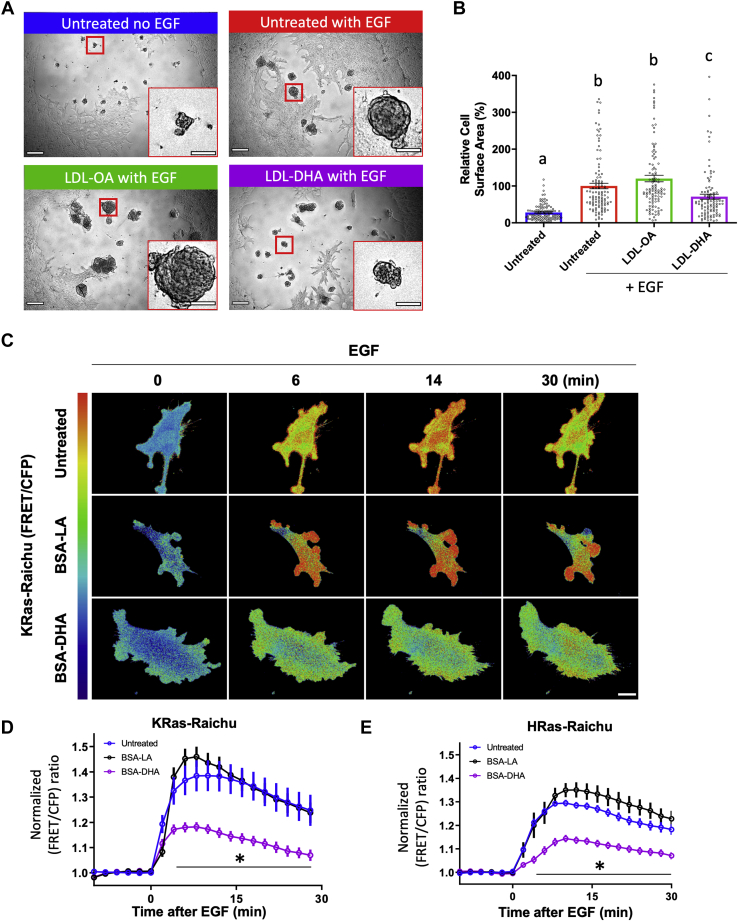
Exogenous supplementation with DHA reduces EGFR-dependent proliferation and downstream signaling in vitro. A: Representative images of colonoids grown with indicated treatments. Scale bar, 300 and 100 μm. B: Quantification of colonoid surface area after 10 days of treatment. Data represent mean ± SE. Number of organoids examined per treatment, Untreated No EGF = 112, Untreated + EGF = 109, LDL-OA + EGF = 109, LDL-DHA + EGF = 112, from eight wells per group from two independent experiments. Statistical significance between treatments as indicated by uncommon letters (P < 0.05) was examined using one-way ANOVA and uncorrected Fisher's LSD tests. C: Spatiotemporal activation of Ras was determined by monitoring activation of FRET biosensors targeted to (D) K- or (E) H-Ras domains. C: Representative intensity-modulated images of KRas-Raichu–expressing cells at various time points following EGF stimulation. Scale bar, 20 μm. D: Data represent mean ± SE, FRET ratio for each cell. Number of cells examined per treatment, Untreated = 8, BSA-LA = 11, and LDL-DHA = 8. All points after 4 min are statistically significant (P < 0.05) between BSA-DHA and untreated (control) as indicated by bar and (∗). E: Data represent mean ± SE, FRET ratio for each cell. Number of cells examined per treatment, Untreated = 26, BSA-LA = 10, and LDL-DHA = 22. All points after 4 min are statistically significant (P < 0.05) between BSA-DHA and untreated (control) as indicated by bar and (∗).